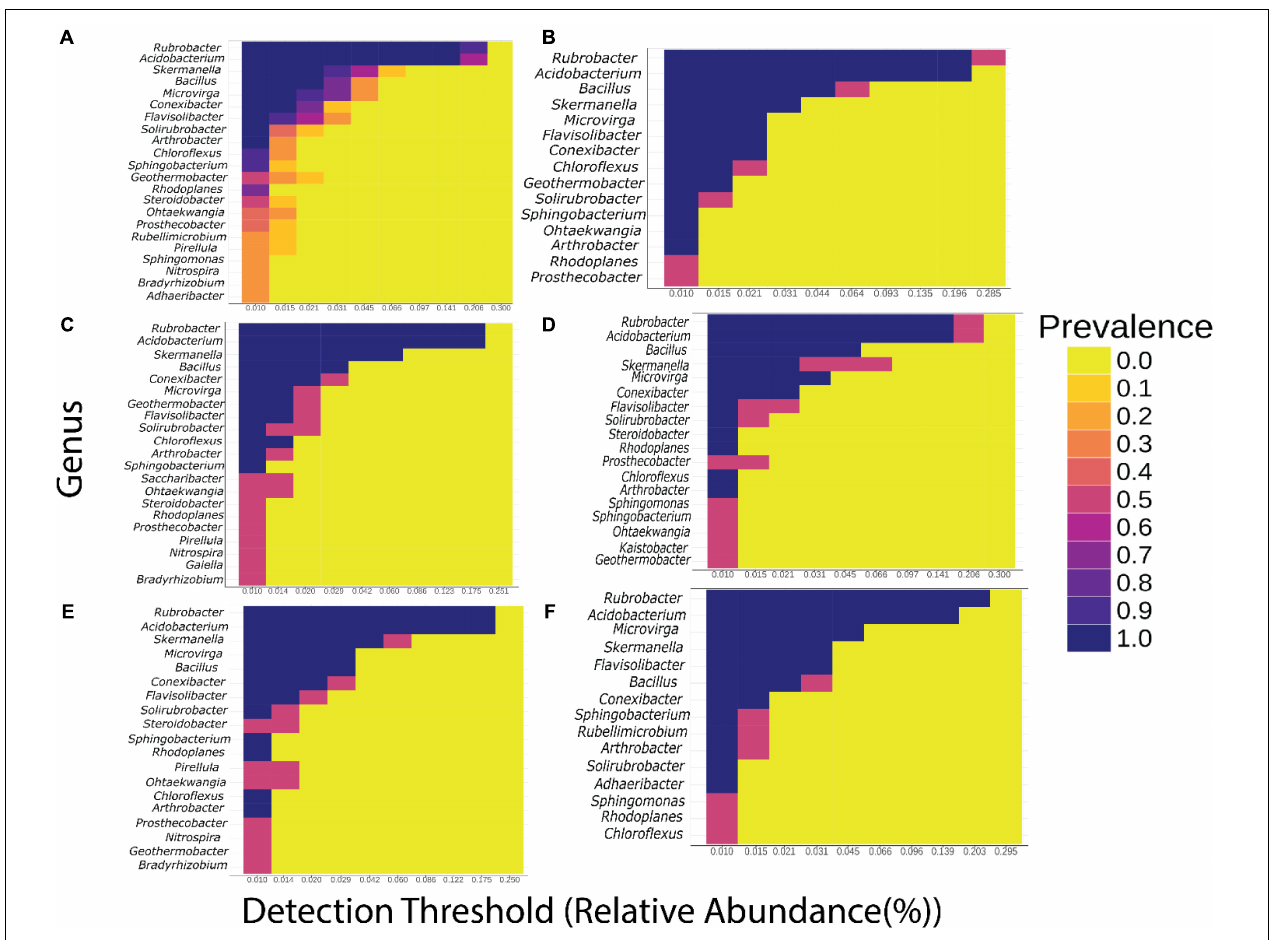
FIGURE 2 | Heatmap of the core bacterial genera. x -axis, relative abundance; colors indicate the prevalence in the sample. (A) Rhizosphere soil, (B) bulk soil [0], (C) vegetative growth stage [4WAP], (D) flowering stage [8WAP], (E) pod-filling stage [12WAP], and (F) maturation stage